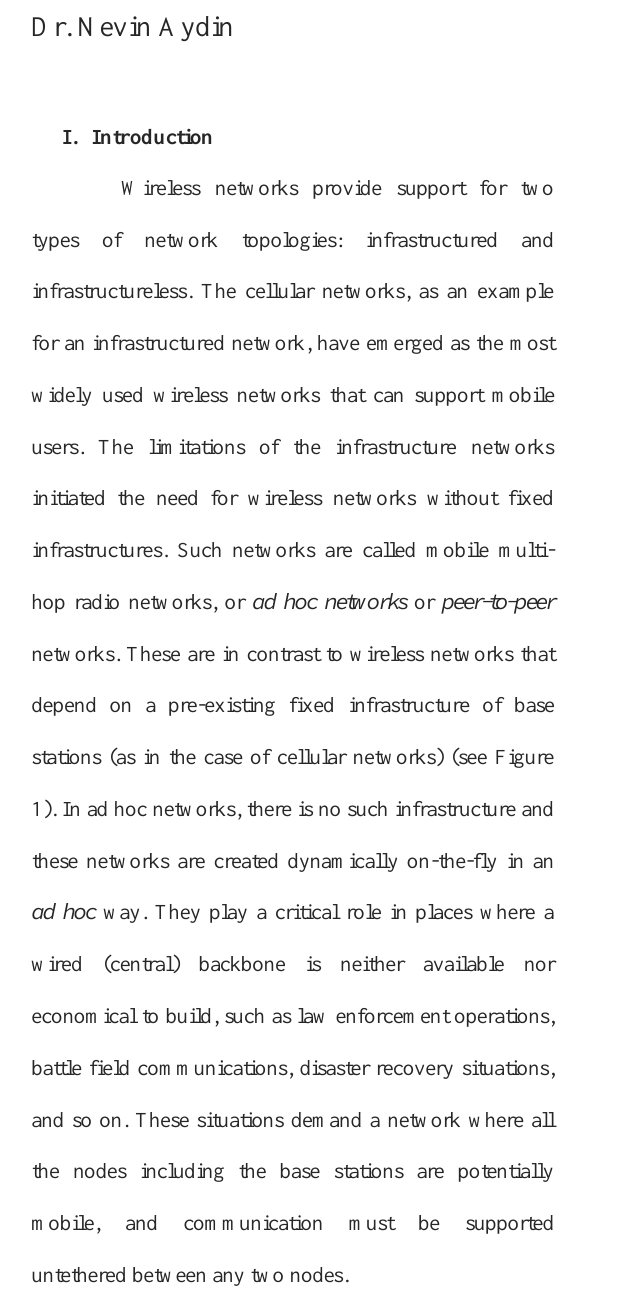
Figure 1. Cellular